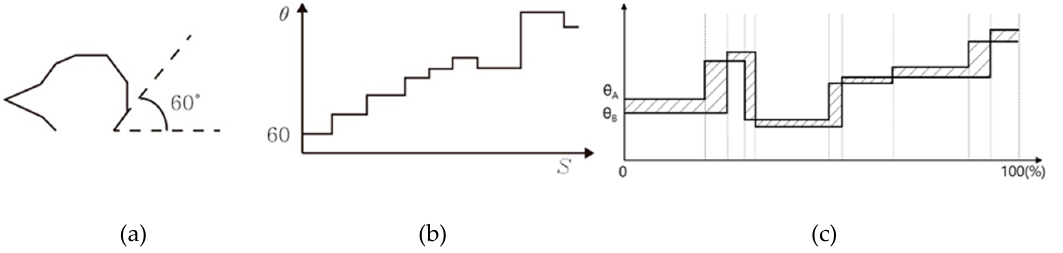
Figure 5. Turning function analysis: ( a ) calculating rotational angles and polygonal chain length, ( b ) plotting rotational angles and ratios of polygonal chain lengths, and ( c ) comparing shape similarities by calculating the area difference.